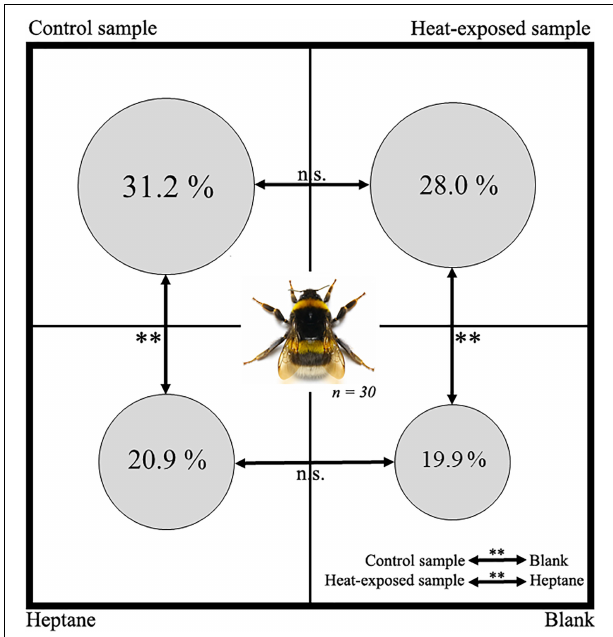
FIGURE 2 | Ethological bioassays. Diagram showing the percentage of time spent by the virgin bumblebees queen ( B. terrestris ) in each quarter of the apparatus during ethological bioassays according to the solution present on the filter paper. Control sample, filter paper with pheromones from non-stressed males; Heptane, filter paper with heptane; Heat-exposed sample, filter paper with pheromones from heat-exposed males; Blank, unsoaked filter paper; bi-directional arrows represent statistical comparison between groups; n.s., non-significative difference; ∗∗ , significative difference p < 0.01, Kruskal–Wallis multiple comparison